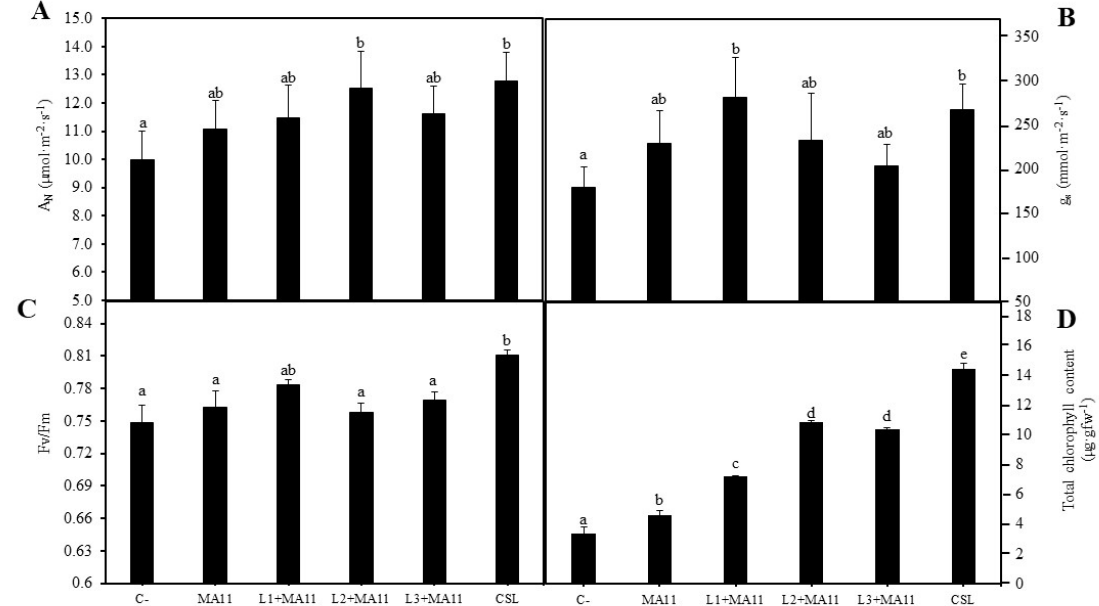
Figure 4. Photosynthetic parameters. ( A ) Net photosynthetic rate, ( B ) stomatal conductance, ( C ) maximum quantum efficiency of PSII photochemistry, and ( D ) total chlorophyll content in plants of M. sativa after 60 days from germination under greenhouse conditions with a nutrient-poor soil as substrate and different inoculation treatments. Values are mean ± S.D. ( n = 16). Different letters indicate means that are significantly different from each other (one-way ANOVA; LSD test, p < 0.005). C-: without inoculation; MA11: inoculation with strain MA11; L1+MA11: inoculation with strains L1 and MA11; L2+MA1: inoculation with strains L2 and MA11; L3+MA11: inoculation with strains L3 and MA11; CSL: inoculation with a consortium of strains L1, L2, L3, and MA11.